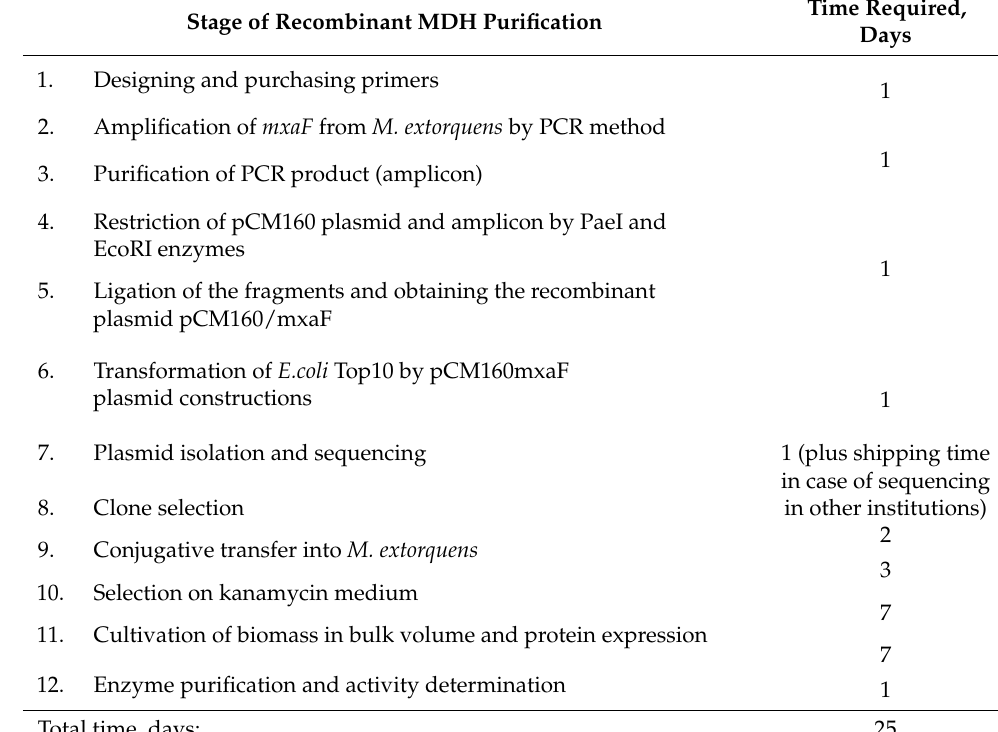
Table 5. The sequence of stages of obtaining the recombinant MDH by homologous expression method. Stage of Recombinant MDH